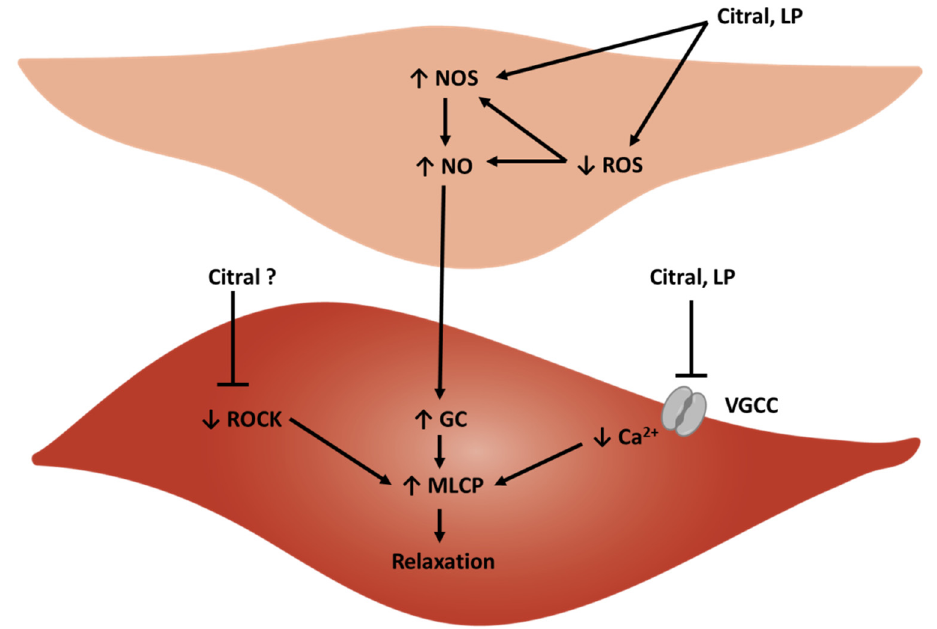
Figure 3. Scheme of the probable vasorelaxation mechanisms of citral and of lemongrass products (LP). An endothelial cell is represented on top and a vascular smooth muscle cell at the bottom (GC—guanylyl cyclase; MLCP—myosin light-chain phosphatase; NO—nitric oxide; NOS—nitric oxide synthase; ROCK—Rho-associated protein kinase; ROS—reactive oxygen species; VGCC—voltage-gated calcium channel).